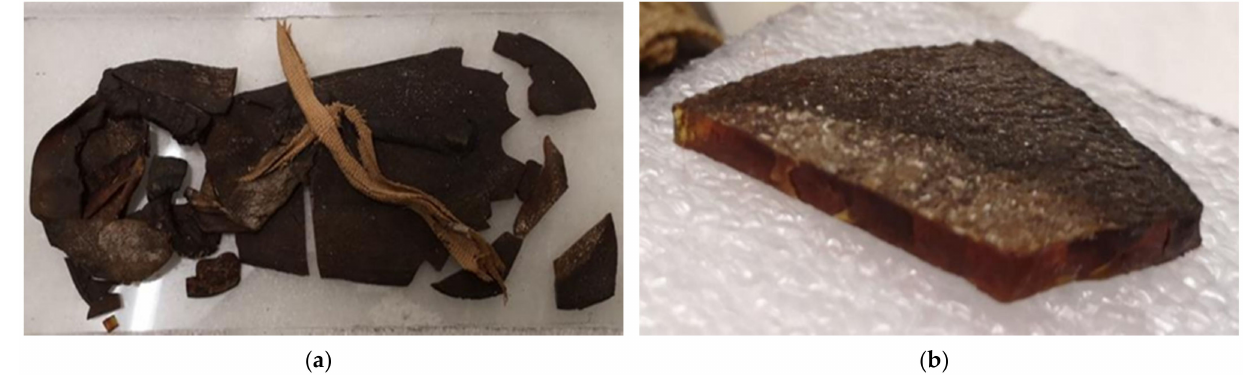
Figure 1. Leather artifacts Inv. N ◦ S. 08640: ( a ) Fragmentary and ( b ) completely